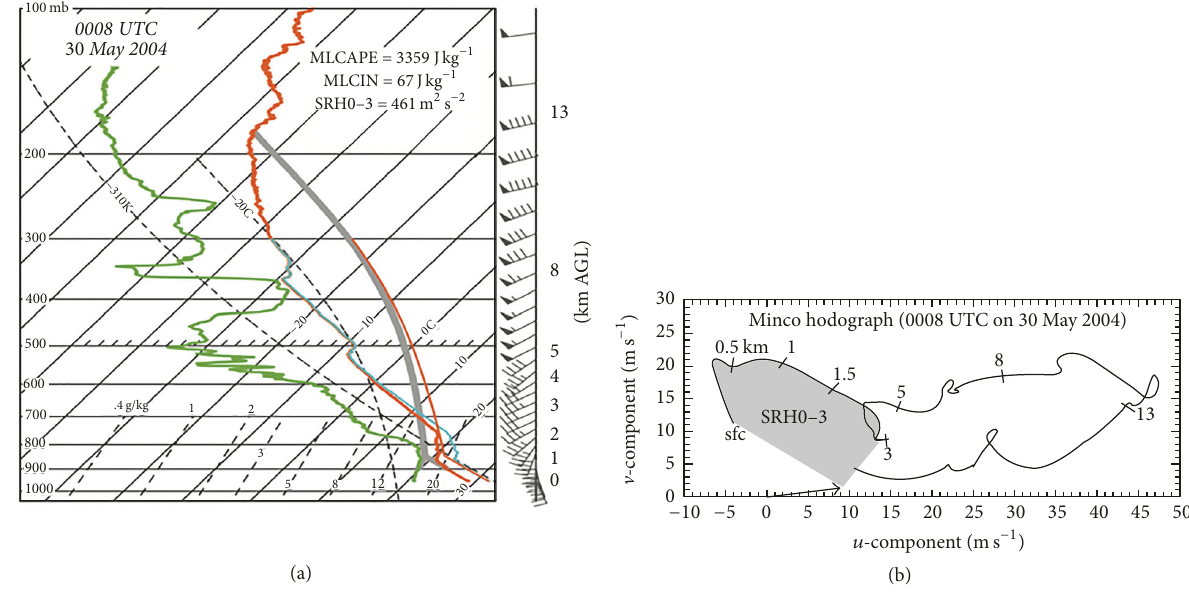
Figure 2: MGAUS sounding in Minco, OK, at 0008 UTC on 30 May 2004. In (a) is the thermodynamic sounding with parameters in the upper right-hand corner. In (b) is the hodograph with the 0–3 km storm-relative helicity shaded in grey and an arrow indicating the average storm